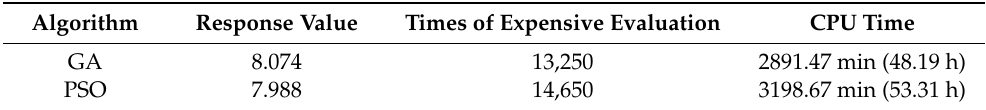
Table 11. The times of expensive evaluation and the CPU time of the traditional methods to obtain